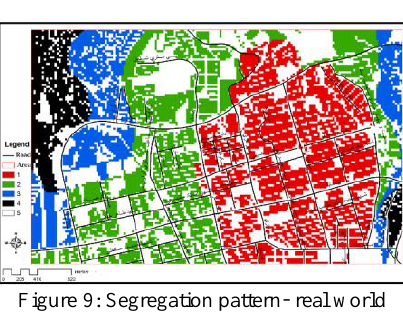
Figure 8: Segregation pattern- model output